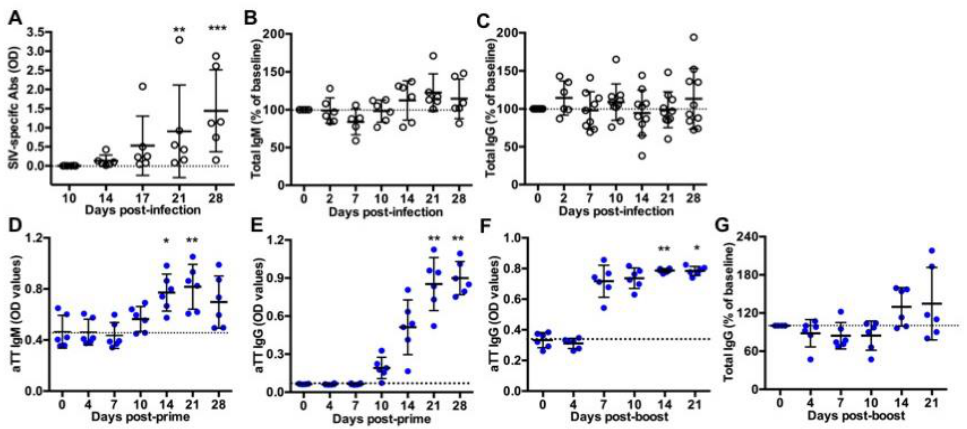
Figure 1. Titers of circulating antibodies in SIV-infected and TT-vaccinated macaques. ELISA was used to quantify ( A ) SIV-specific antibodies, ( B ) total IgM or ( C ) total IgG in plasma from SIV-infected macaques; ( D ) TT-specific IgM and ( E ) TT-specific IgG in serum from vaccinated macaques after the prime or ( F ) after the boost; and ( G ) total IgG in serum from TT-boosted animals. Values of specific TT- and SIV-specific Abs are given in OD values ( A , D – F ). Changes in total IgM and IgG concentration were expressed as the percentage of baseline value for each animal ( B , C , G ). A dotted line indicates the baseline value at D0. Each dot represents one macaque from Group SIV + ( open circle ) or TT ( blue circle ). Bars represent Mean ± SD. Statistical comparison between values at D0 and at every time point was performed using Friedman test with Dunn’s multiple comparisons test. * p < 0.05 , ** p < 0.01 and *** p < 0.001 .